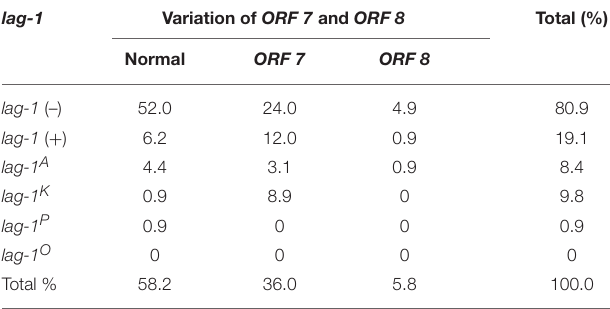
TABLE 2 | Japanese environmental isolates ( n = 225) were divided into 15 subgroups of sg1. lag-1